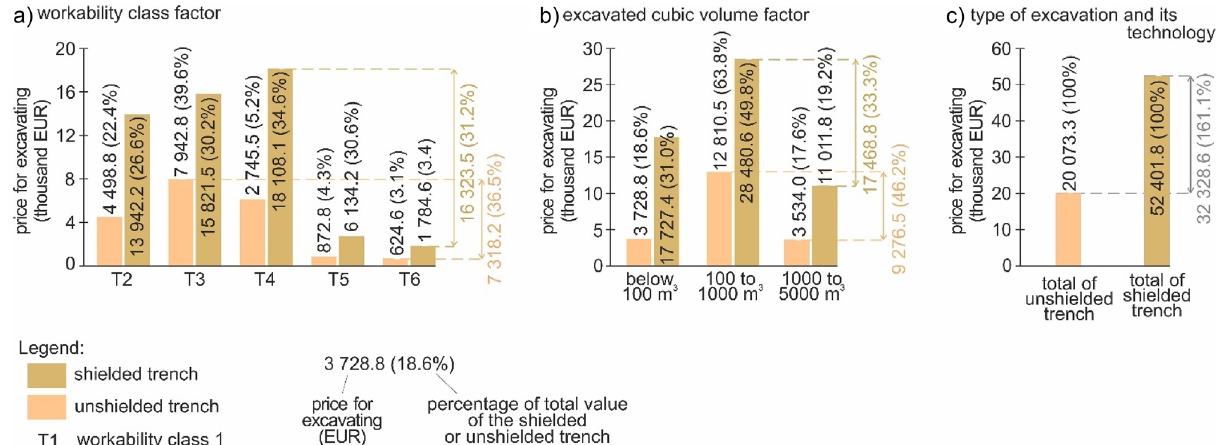
Figure 11. Graphs of different earthwork factor influence on the price of excavations (study 2a—unshielded trench, the first column; study 2b—shielded trench, the second column), ( a ) workability class factor; ( b ) excavated cubic volume factor; ( c ) type of excavation and its